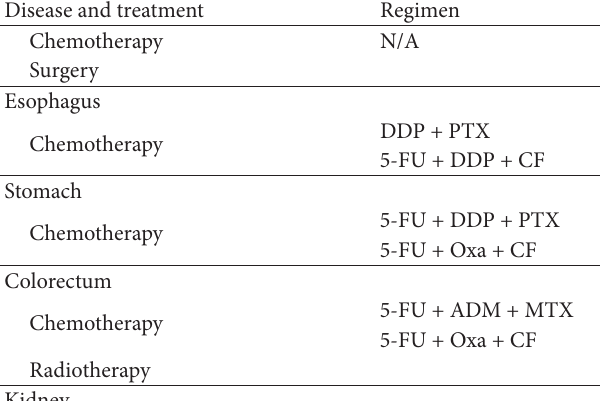
Figure 1: Chronological analysis of the rate of adverse events of HIFU during 2000–2012. There was no downtrend in either malignant or benign disease